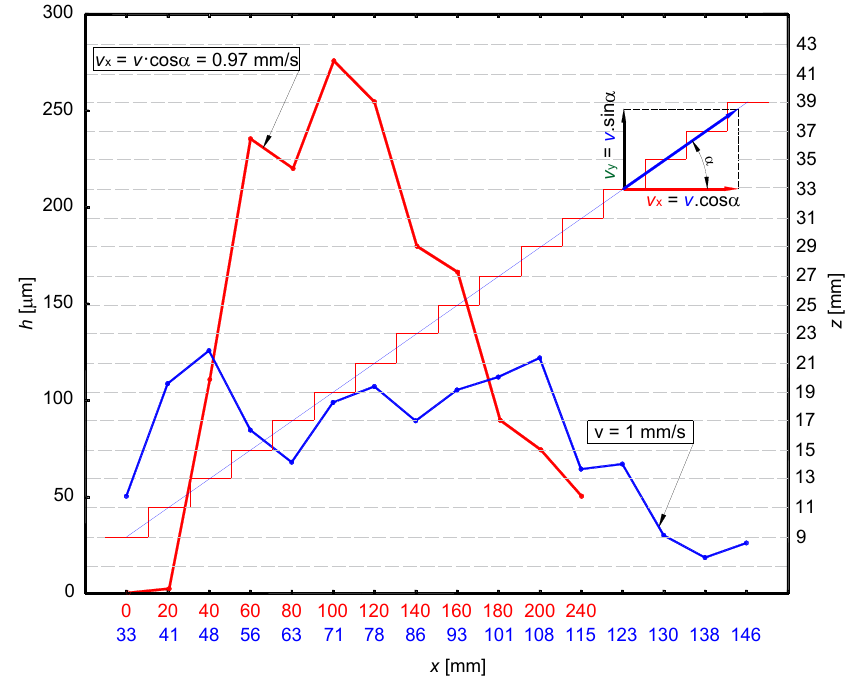
Figure 1. Results comparing the effect of trajectory with constant traverse speed. The experimental conditions are provided in Table 4. The lowest standoff distance, z = 5 mm, was estimated from previous experiments. The nozzle trajectory followed the direct motion of 20 mm with further vertical motion of 2 mm in the standoff distance. The subsequent motion of the nozzle was repeated up to the maximum standoff distance of z = 101 mm (Figure 2). A sufficient edge distance was maintained with the traces, with a consecutive distance of 15 mm between each trace to avoid overlapping. The trajectory was repeated for varying traverse speeds ranging from 5 to 35